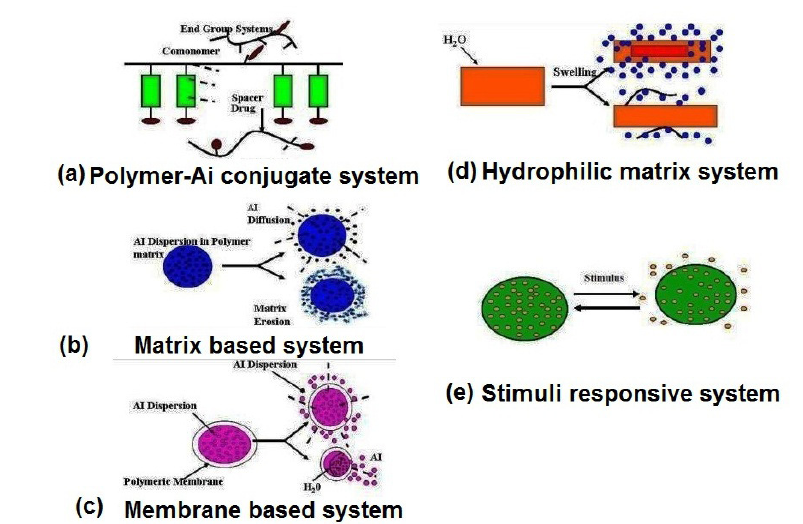
Figure 3. Controlled release systems: (a) polymer-AI conjugate, (b) matrix based, (c) membrane based, (d) hydrophilic matrix, and (e) stimulus